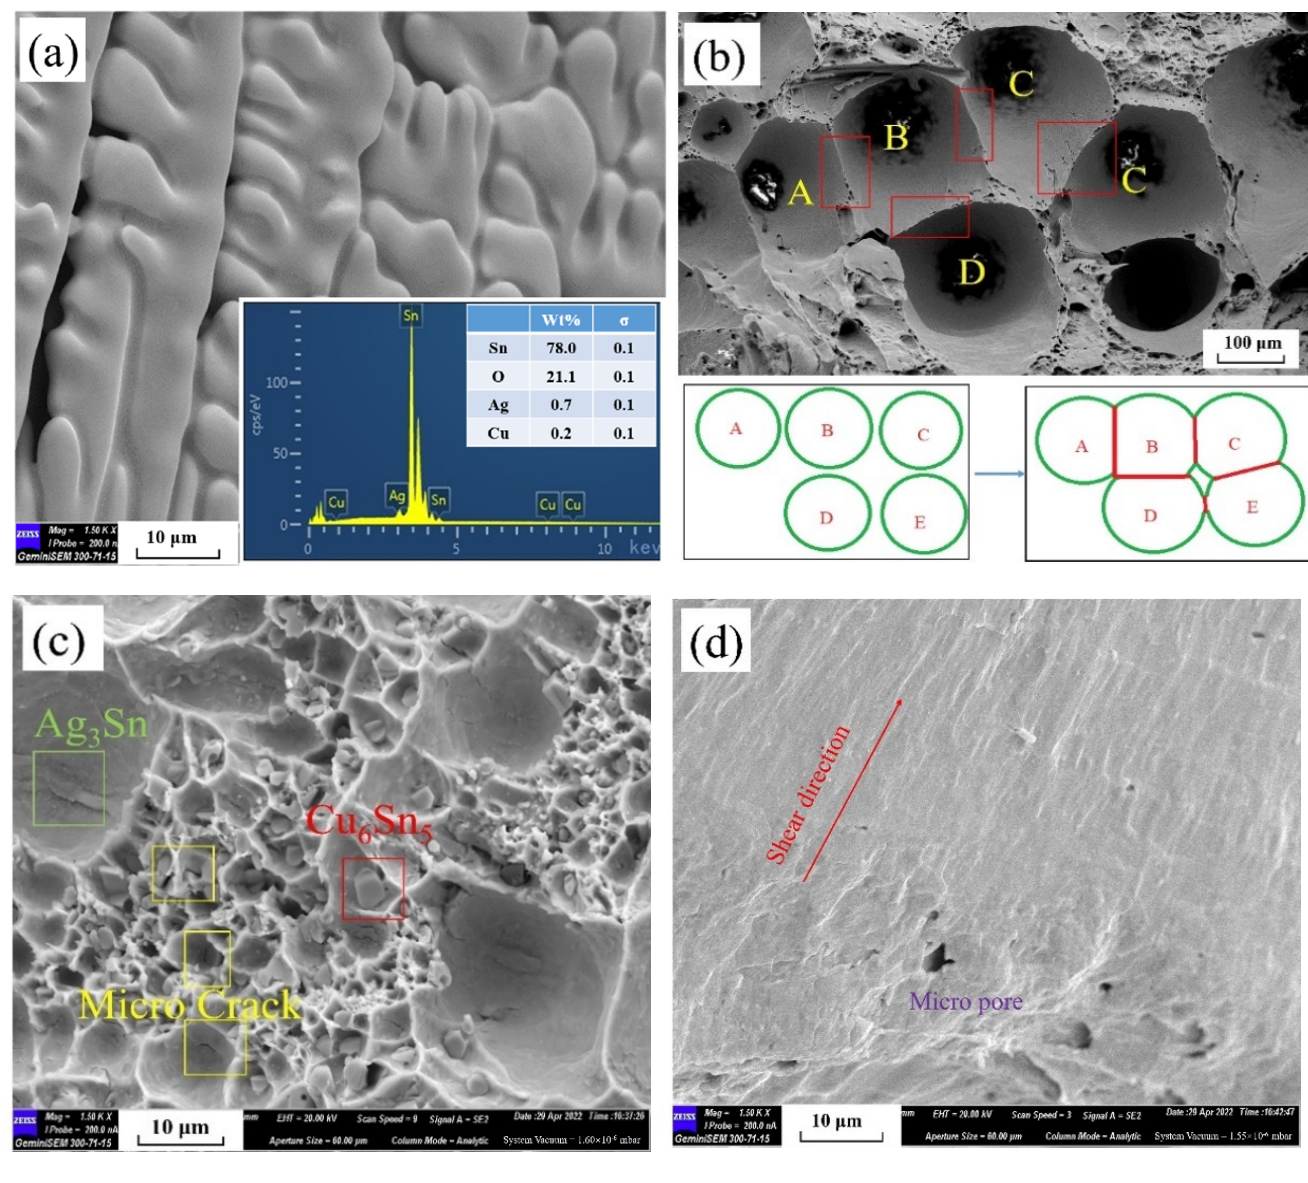
Figure 13. Partially enlarged image: ( a ) Q1 region; ( b ) pores in Q3 region; ( c ) fracture surface of IMC layer in Q2 region; ( d ) S4 region.